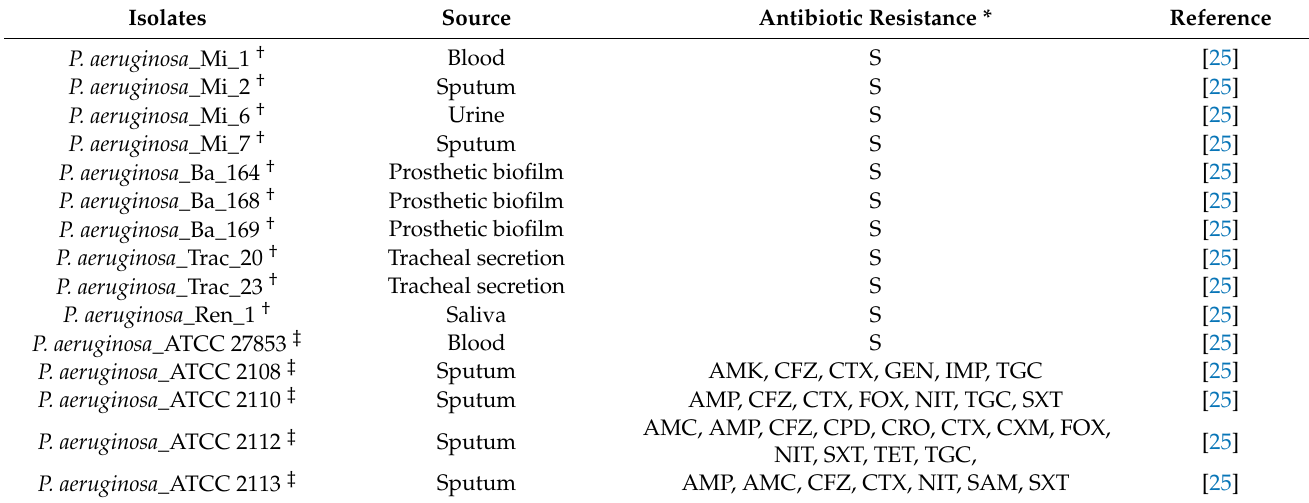
Table 1. Bacterial strains used in the